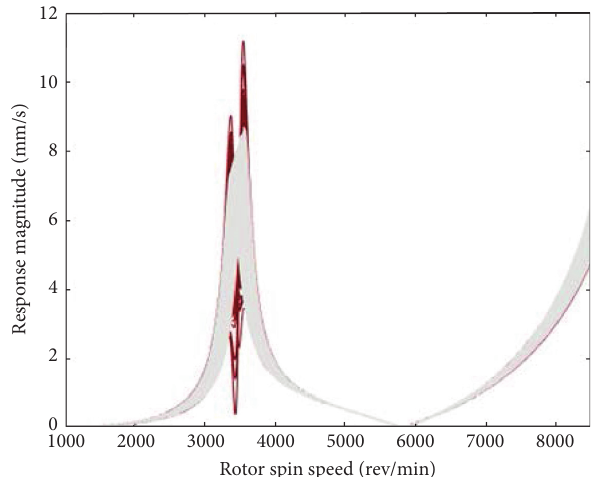
Figure 14: The overlay of comparison of the variation results obtained with Monte Carlo (grey solid line) and the PCE (red solid line) methods.